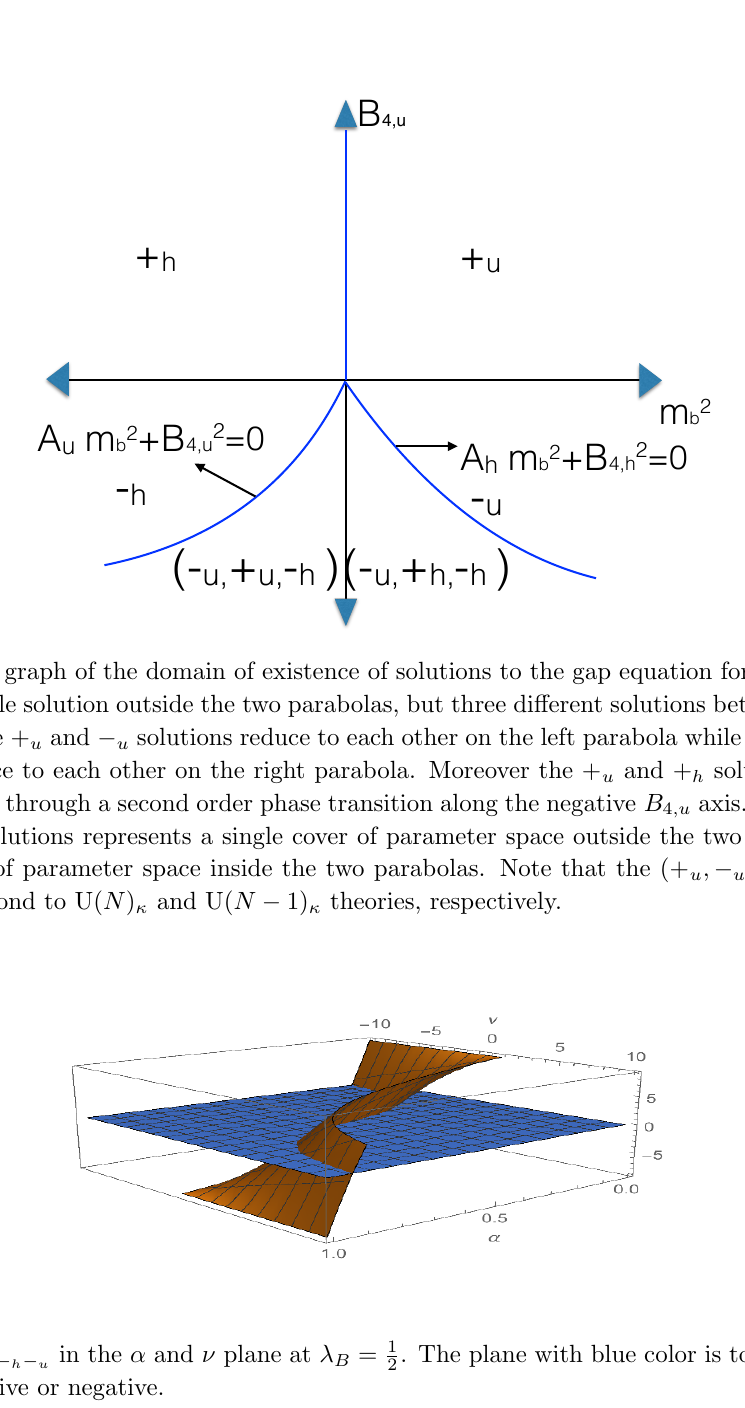
we have plotted in (cid:12)gure 25 plots at di(cid:11)erent values of (cid:21)